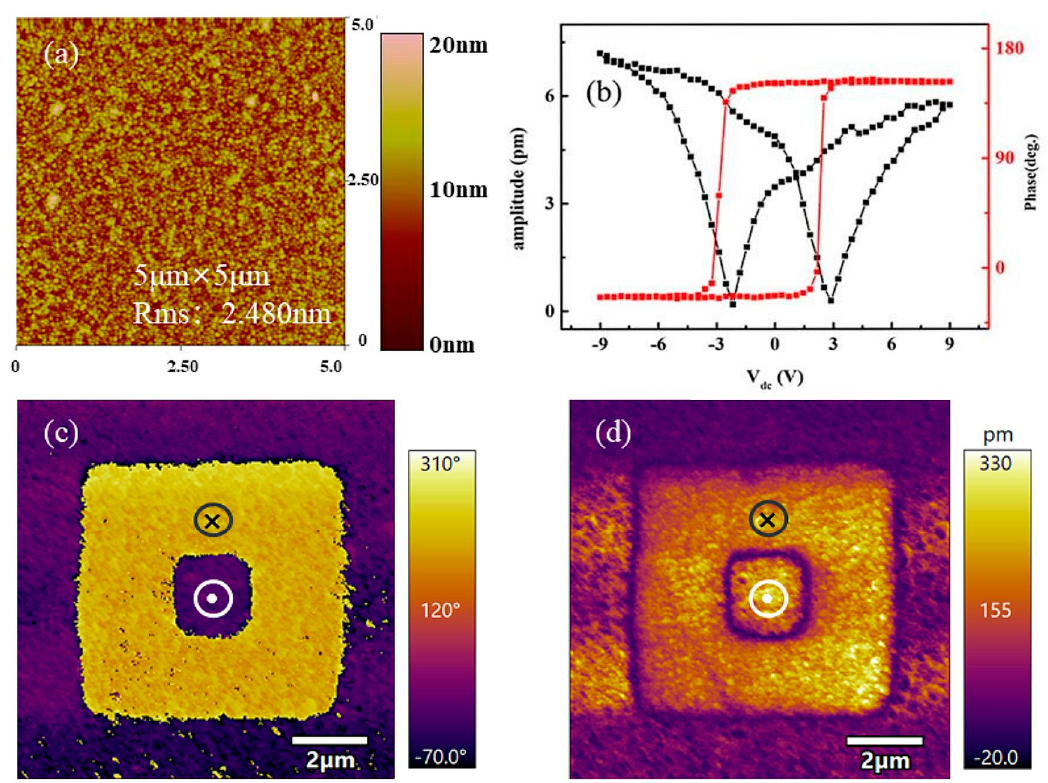
Figure 3. ( a ) Topography. ( b ) Off-field hysteresis loops of amplitude and phase. ( c ) PFM phase. ( d ) PFM amplitude for BTO/LSMO at room temperature.